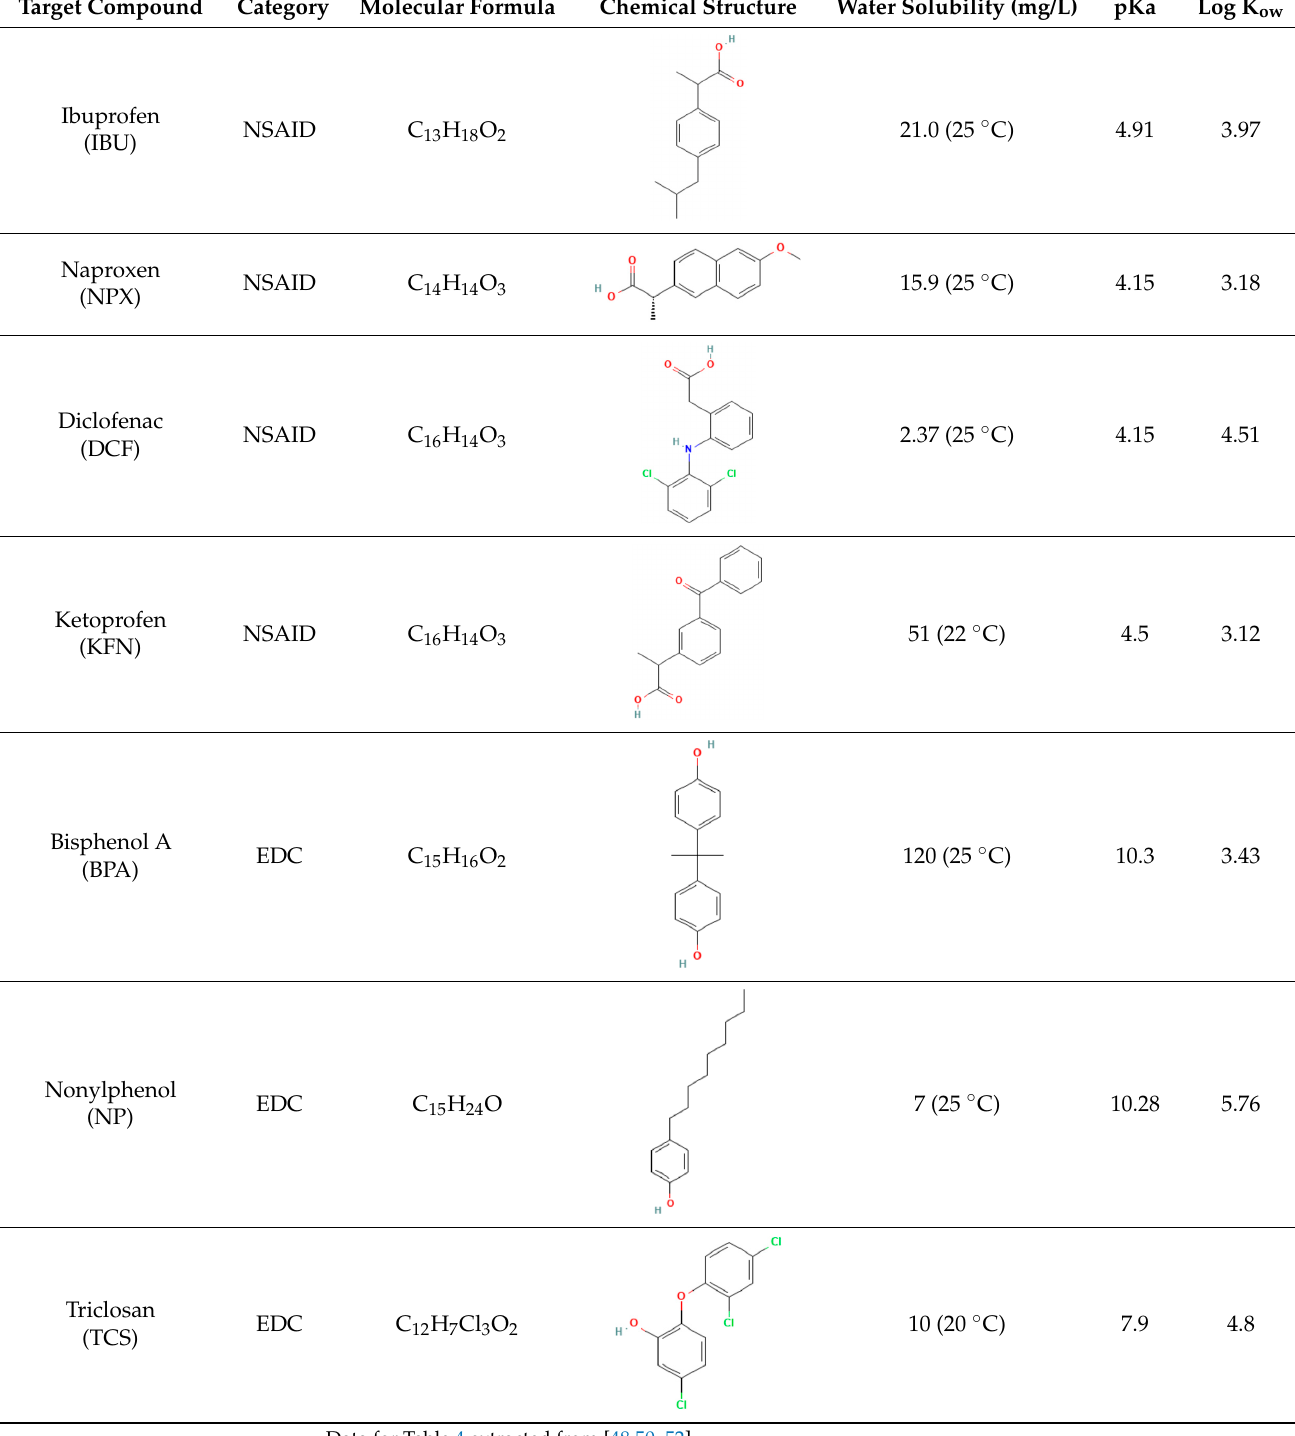
Table 4. Main physicochemical properties and chemical structure of the target compounds.